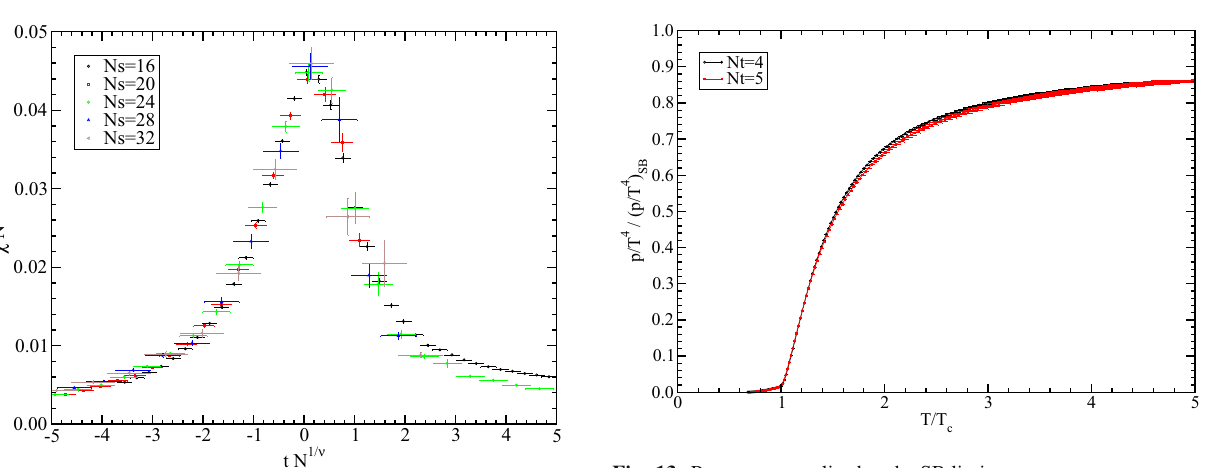
Fig. 13 Pressure normalised to the SB limit